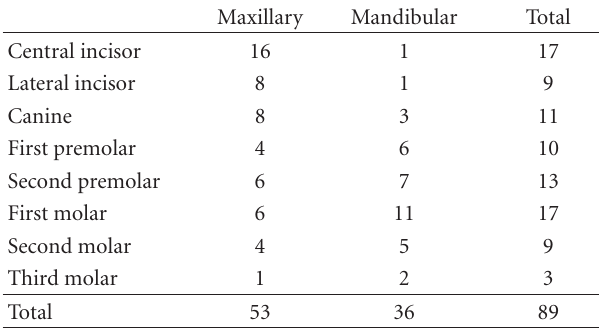
Table 2: Tooth number and location of teeth in the maxillary and mandibular arch evaluated 10 years postoperatively.